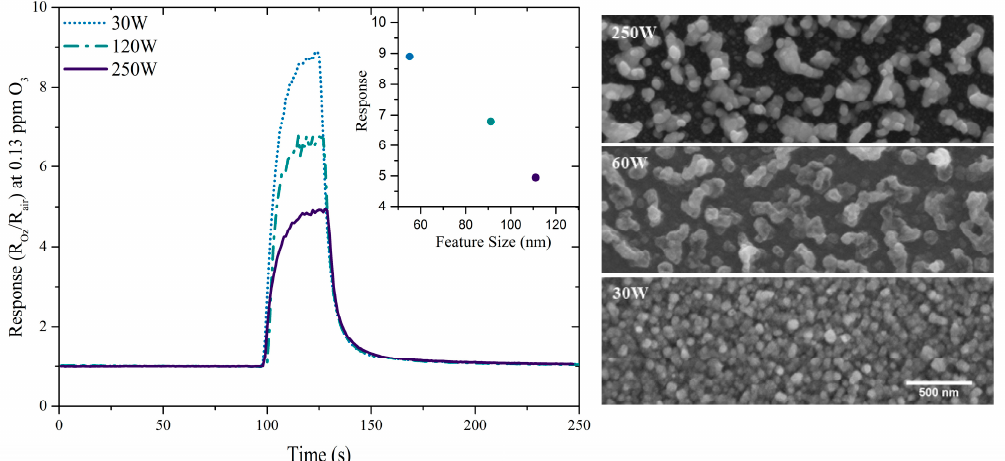
Figure 2. ZnO sputtered films sensing response at 300 °C and gas response in function of the grain size ( left ). SEM images for ZnO films in sensor electrodes ( right